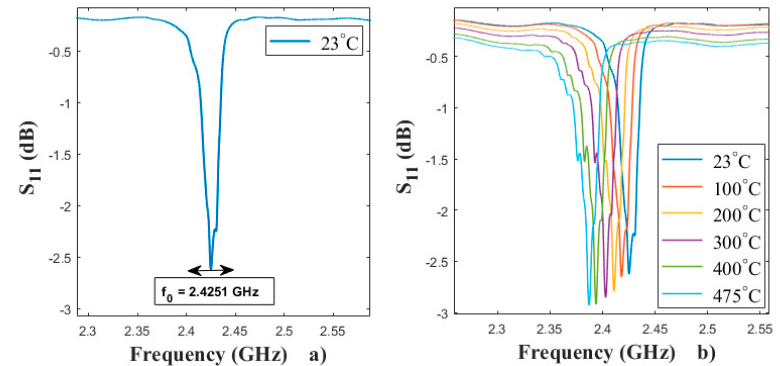
Figure 2. ( a ): Measured reflection coe ffi cient S 11 of the Pt / AlN / Sapphire sensor at 23 ◦ C, ( b ): evolution of the reflection coe ffi cient as a function of the temperature.